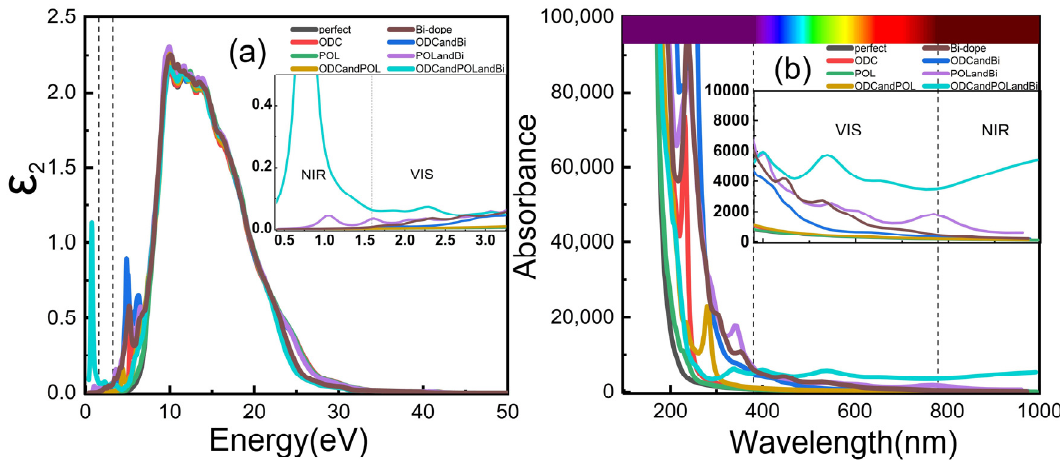
Figure 4. ( a ) Diagram of the imaginary part of the permittivity of silica fiber. ( b ) Absorption spectrum of silica fiber.